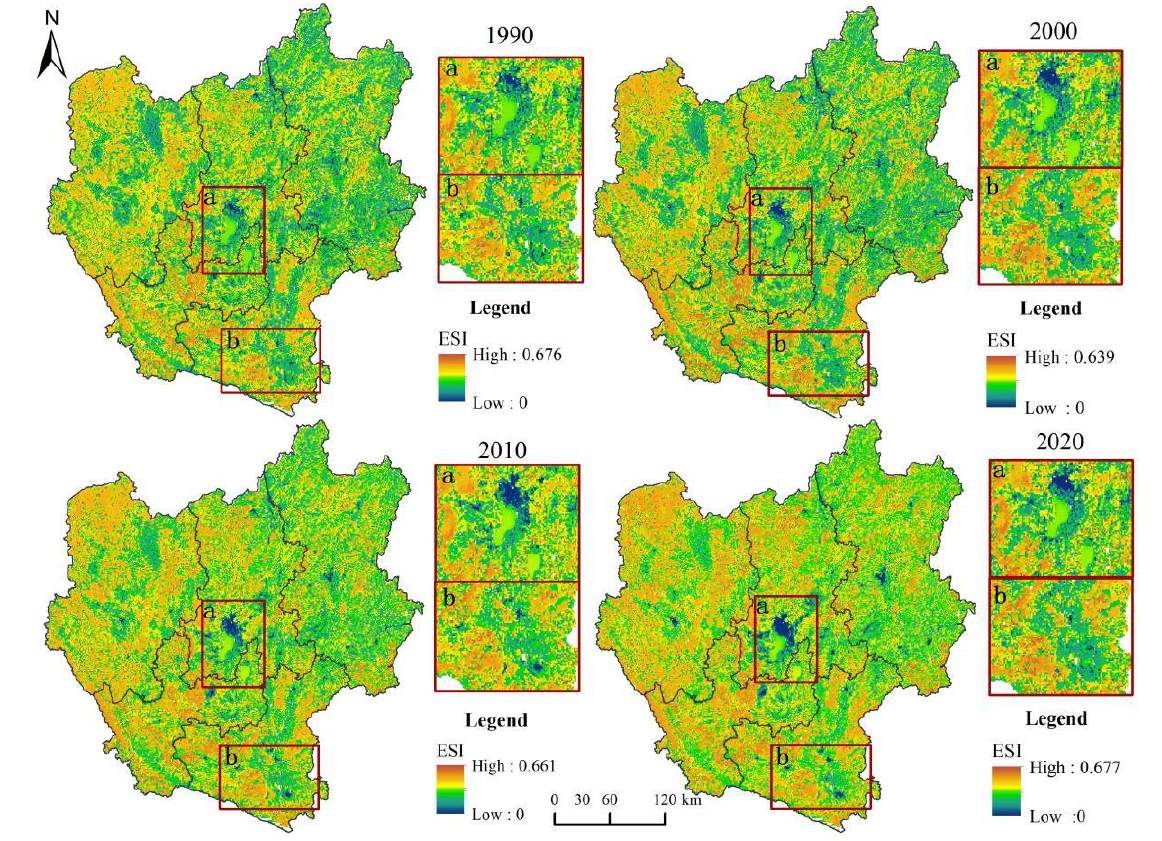
Figure 4. Spatial distribution pattern of ESI of central Yunnan urban agglomeration, 1990 – 2020.